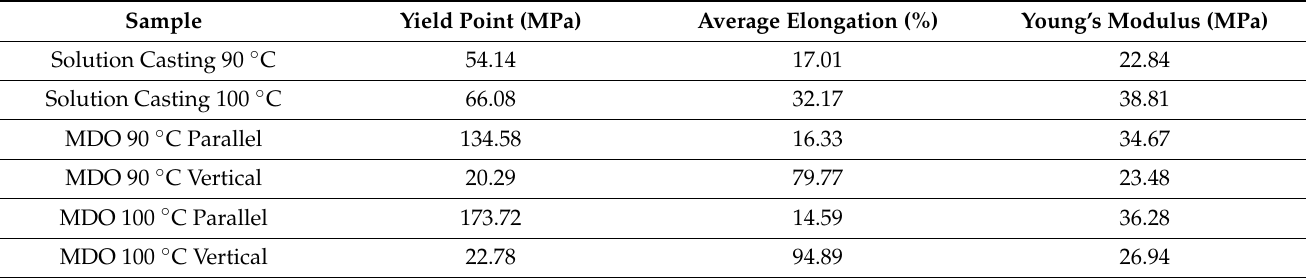
Table 2. Tensile test results of PVDF films with different process